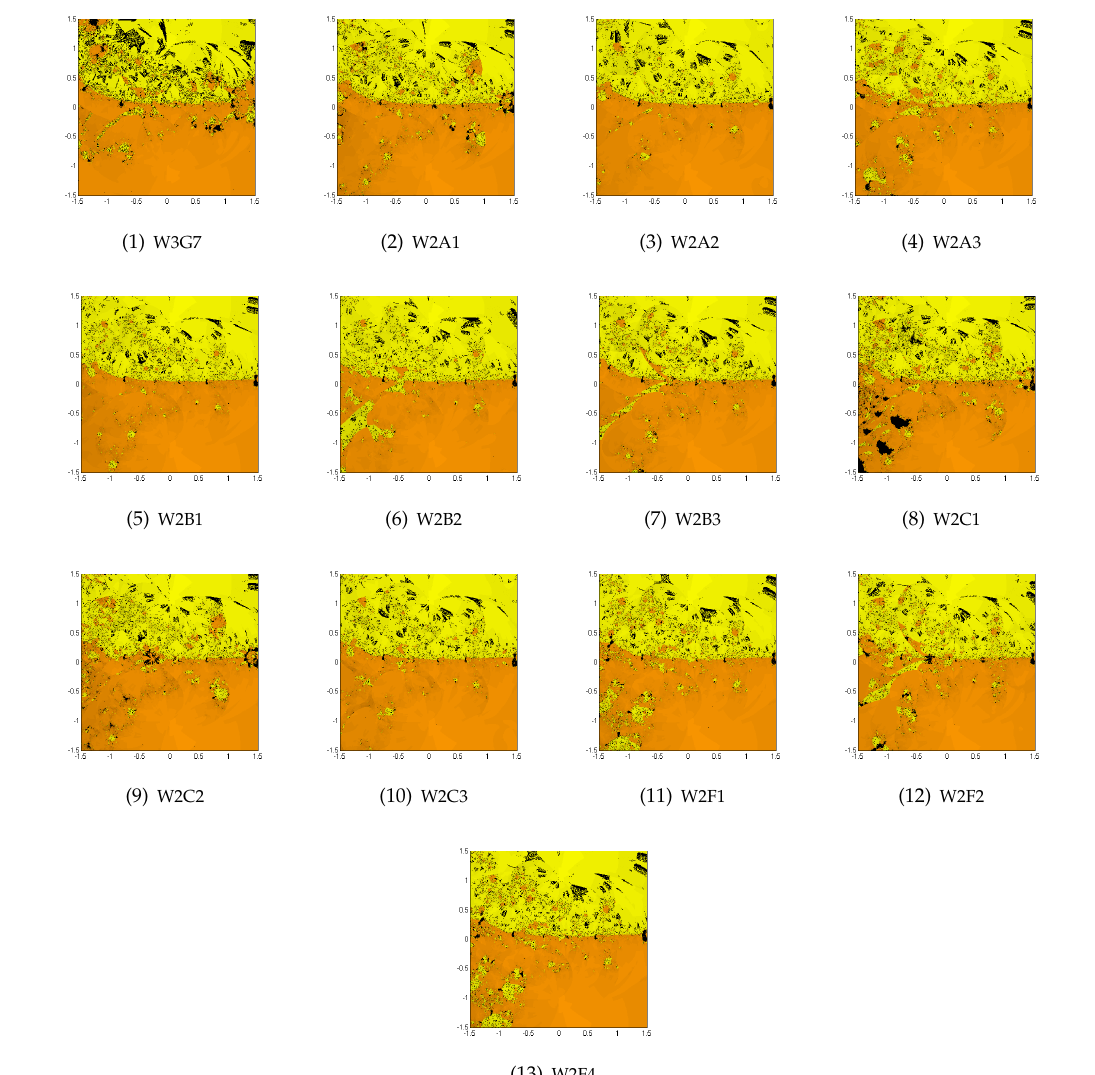
Figure 7. The top row for W3G7 ( left ), W2A1 ( center left ), W2A2 ( center right ) and W2A3 ( right ). The second row for W2B1 ( left ), W2B2 ( center left ), W2B3 ( center right ) and W2C1 ( right ). The third row for W2C2 ( left ), W2C3 ( center left ), W2F1 ( center right ) and W2F2 ( right ). The bottom row for W2F4 ( center ), for the roots of the non-polynomial equation ( z + i ) 3 ( e z − i − 1 ) 3